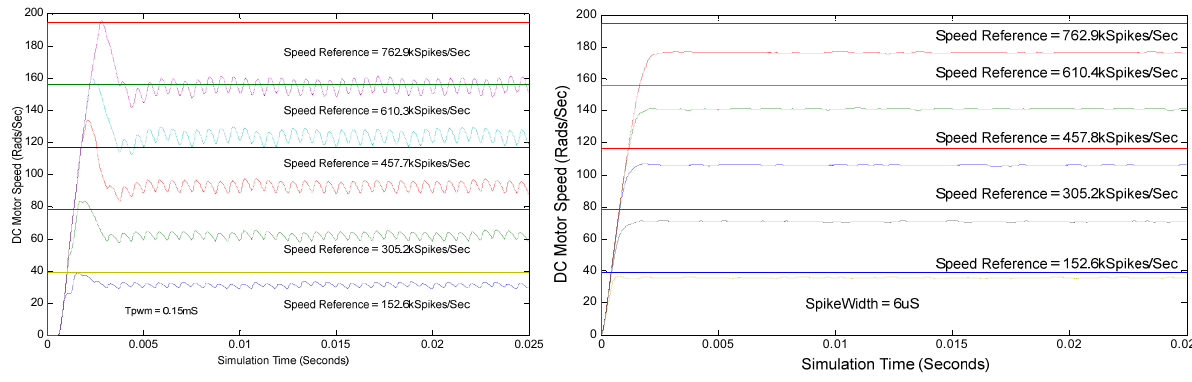
Figure 15. PWM ( left ) vs . PFM ( right ) Proportional close-loop controller